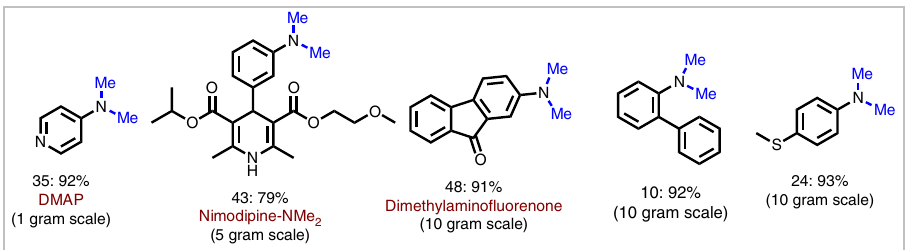
Fig. 7 Gram-scale reactions. Demonstrating the practical utility for the synthesis of selected N -methylamines in up to 10 g. Reaction conditions: 1 – 10 g nitroarenes; 5 mol% Fe 2 O 3 /NGr@C, 300 mg paraformaldehyde (10 mmol) and 1 mmol Na 2 CO 3 for each 0.5 mmol nitroarenes; 40 – 200 mL